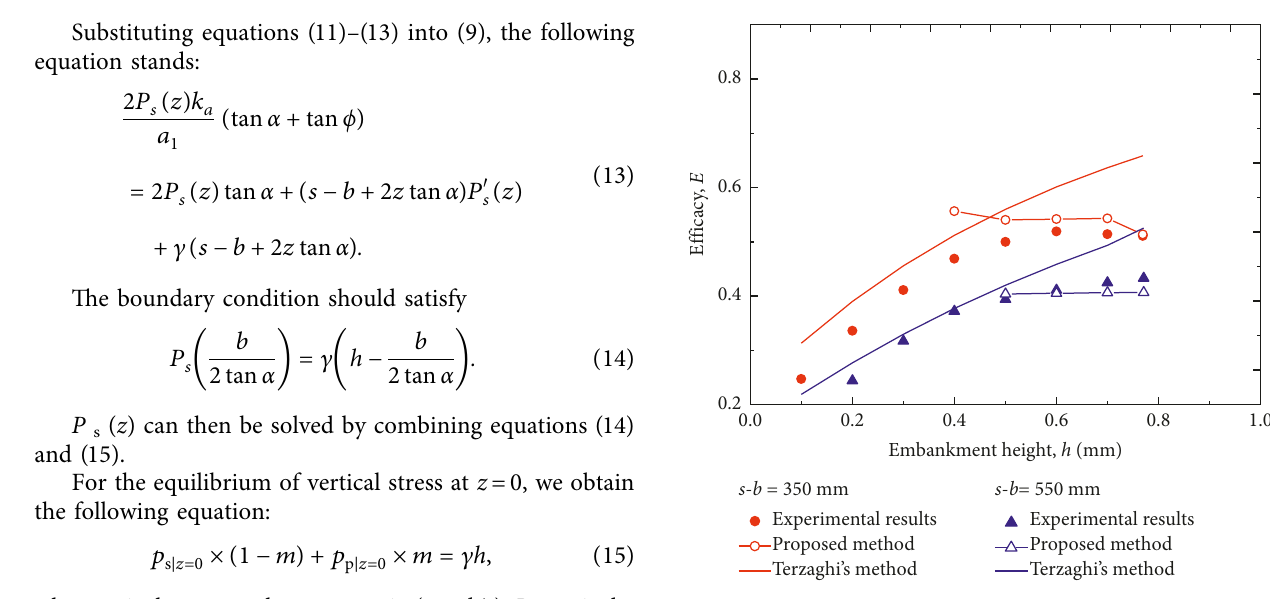
Figure 13: Comparison of the results of the proposed method, Terzaghi’s method, and the